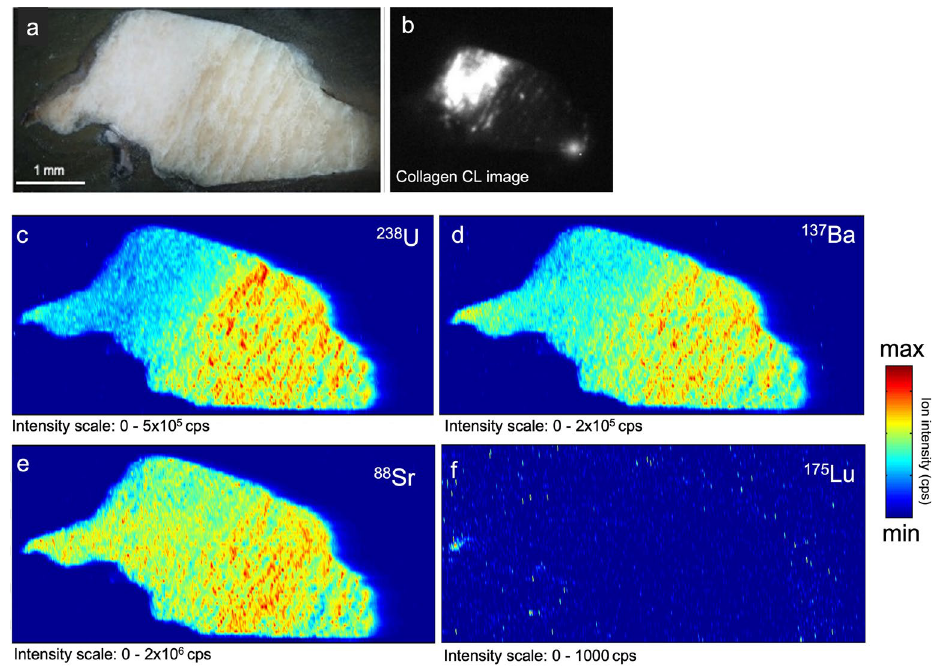
Figure 6. Elemental images of sample S2 obtained by LA-ICPMS. ( a ) Photomicrographs of the sample, ( b ) CL image of the collagen distribution, ( c ) 238 U, ( d ) 137 Ba, ( e ) 88 Sr, ( f ) 175 Lu (as REE content proxy). Note that the elemental images are not reported normalized to an internal standard but as raw cps (counts per second). Maps were obtained using a MATLAB 2010a script 62